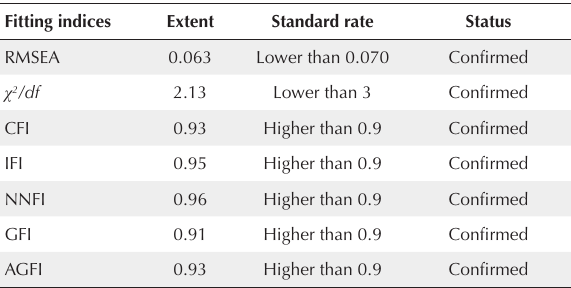
Table 2 . Report on fitting indices of the research model about role of emotional exhaustion on workplace